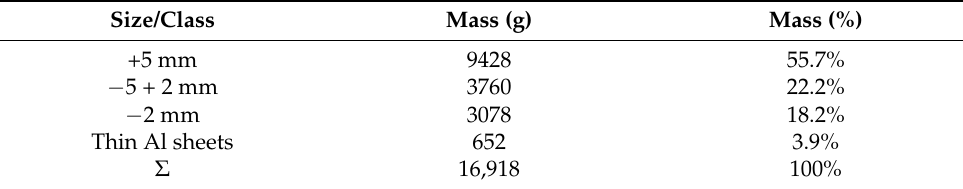
Table 1. Mass fractions obtained after comminution and classification of PCBs.